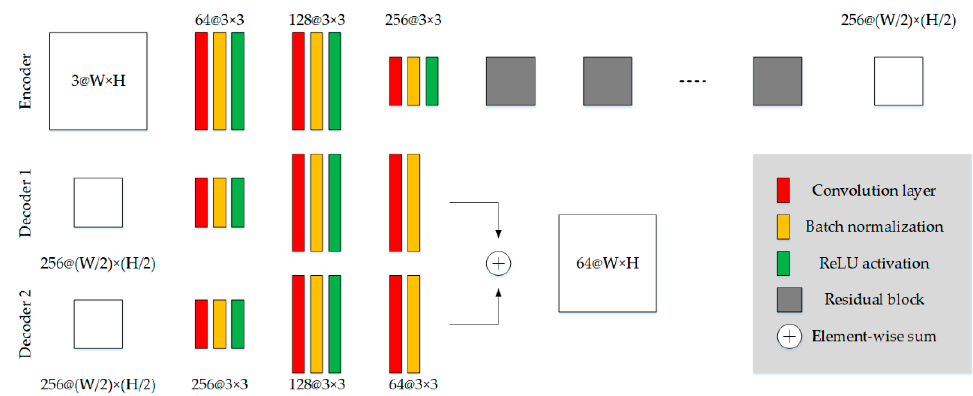
Figure 3. Network architectures of our encoder and decoders.